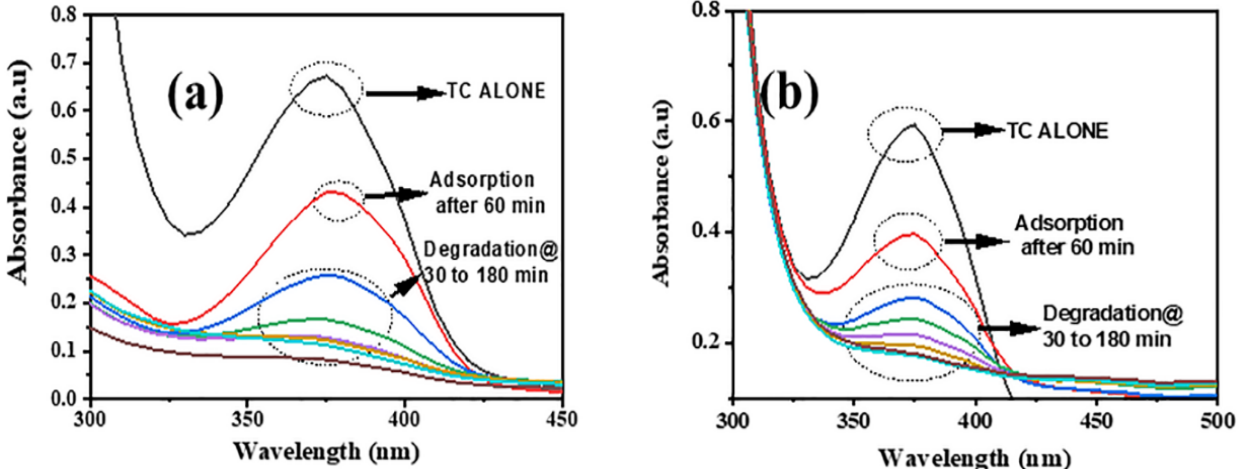
Figure 8. UV-vis absorption spectra of photodegraded TC solution using ( a ) TP-AABR-ACK and ( b ) DP-AABR-ACK. Table 1. Comparison of degradation efficiency of different heterostructures with AABR-ACK composites on tetracycline